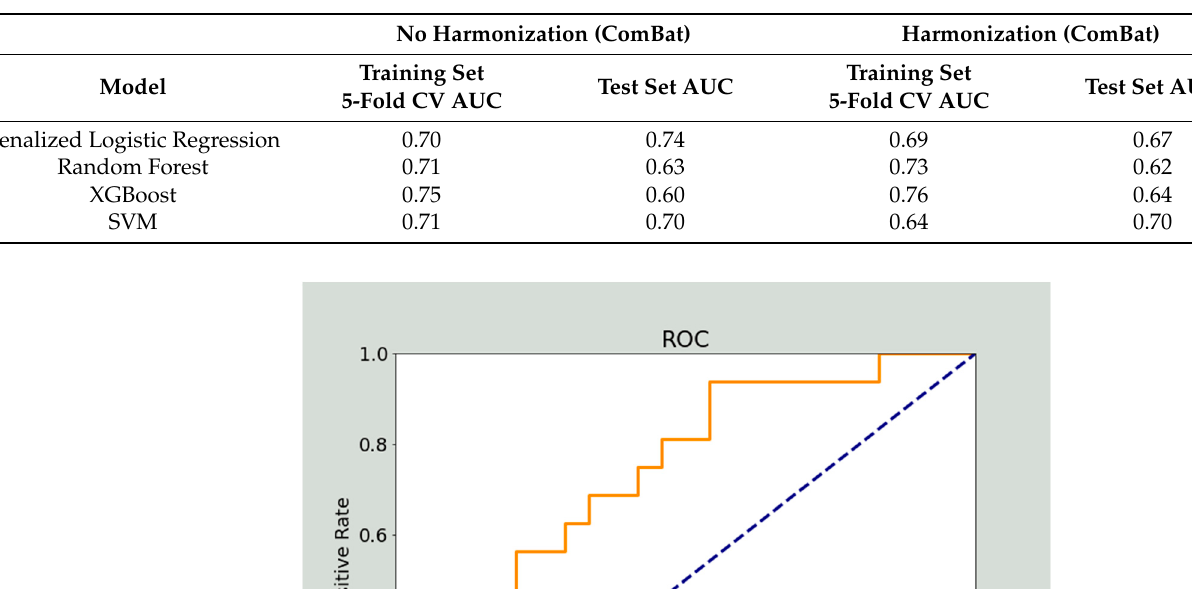
Table 5. Results of the clinical–radiomic models developed for the BRCA classification. Mean AUC of the 5-fold cross-validation (CV) obtained during model training and AUC of the test set for the analysis without or with ComBat harmonization are reported.